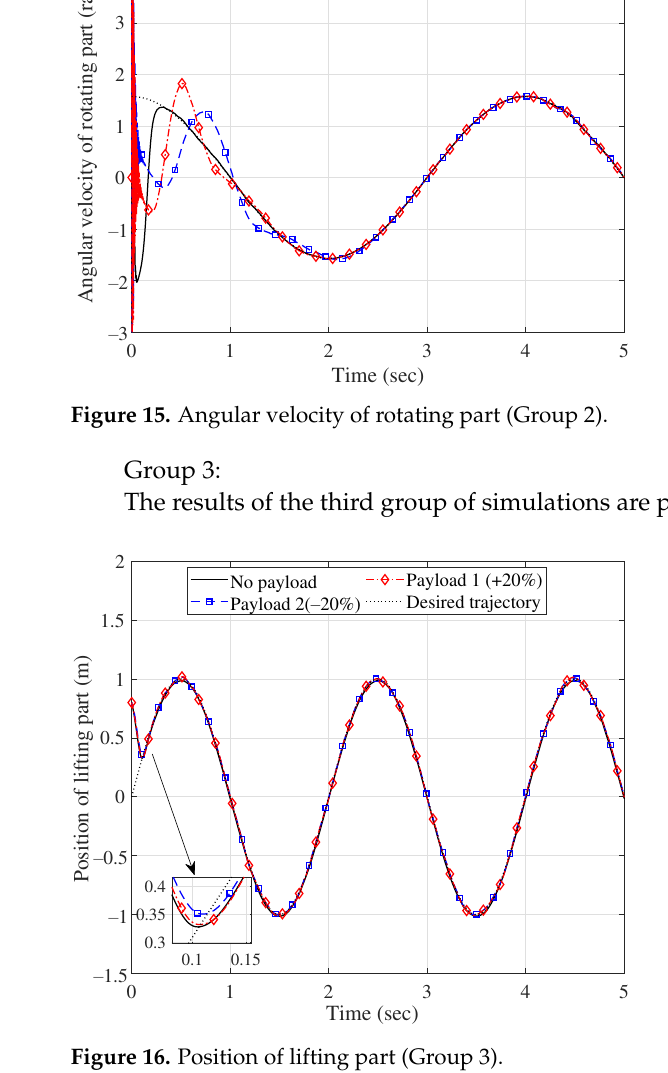
Figure 16. Position of lifting part (Group 3).